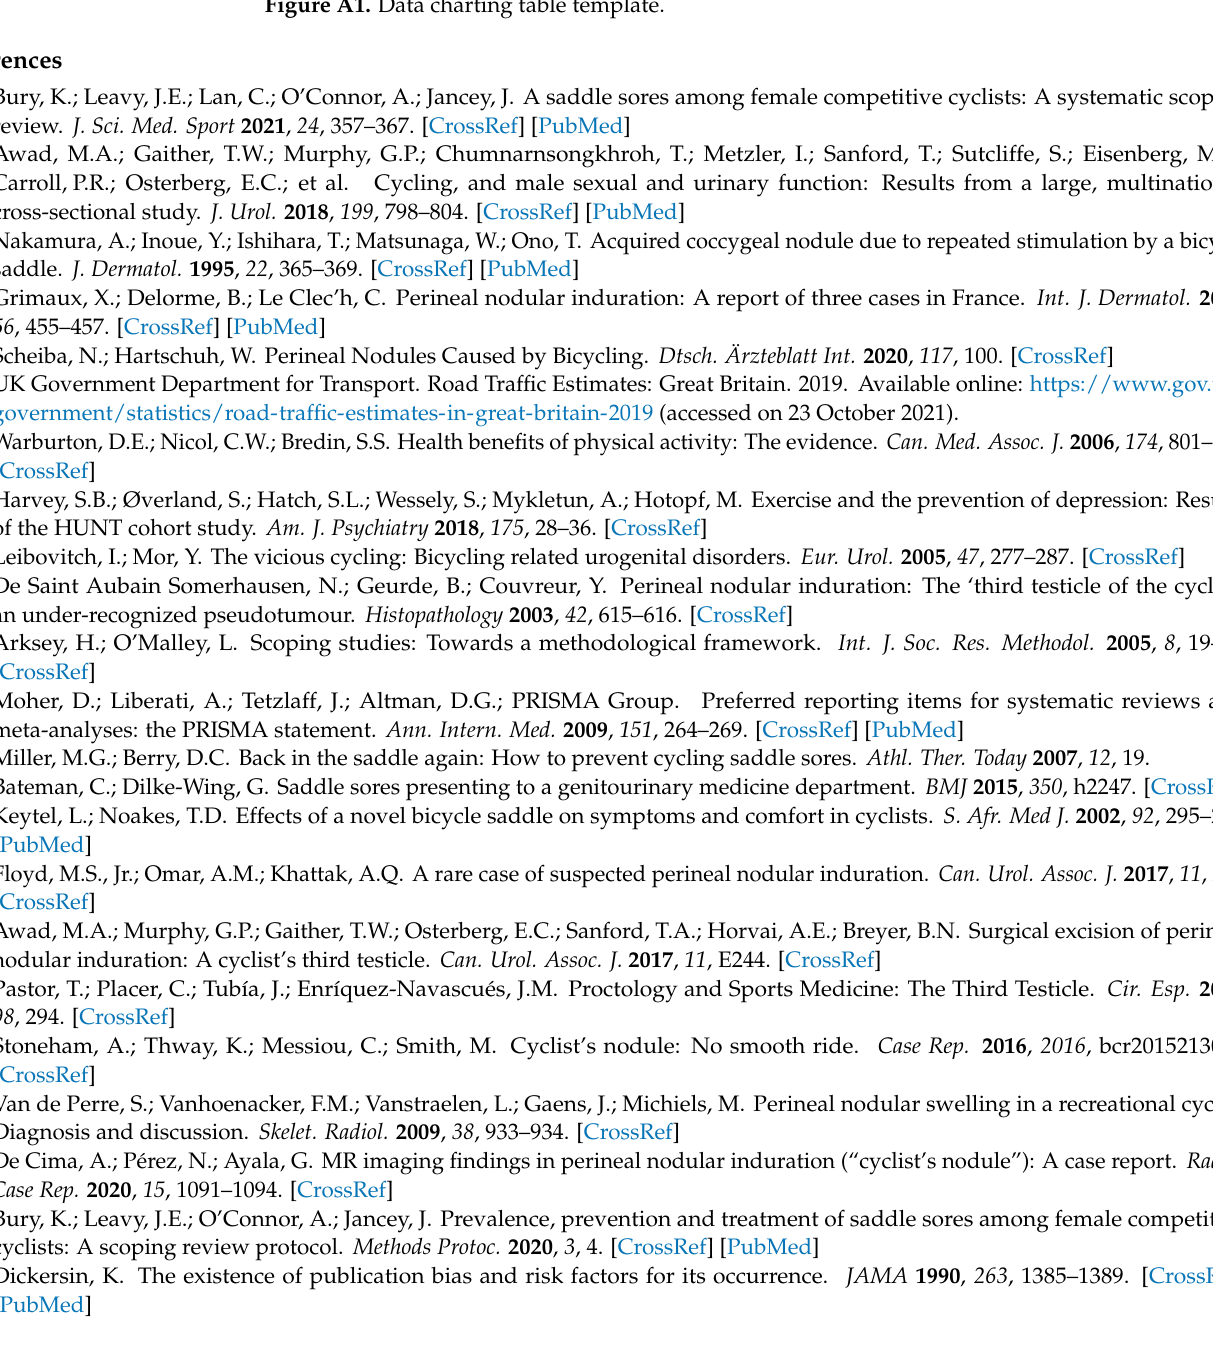
Figure A1. Data charting table